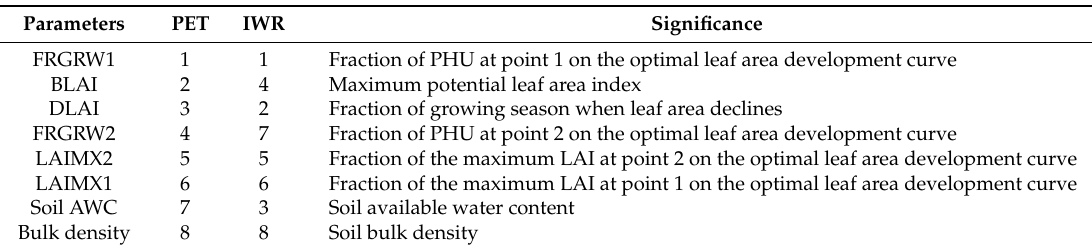
Table 11. Rank of parameter sensitivity for annual crop PET and